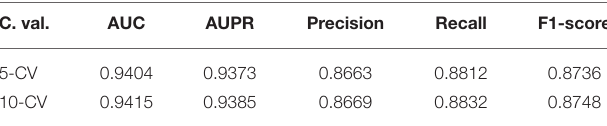
TABLE 1 | The results of 5-fold and 10-fold cross-validation obtained by PMDFI. C. val.